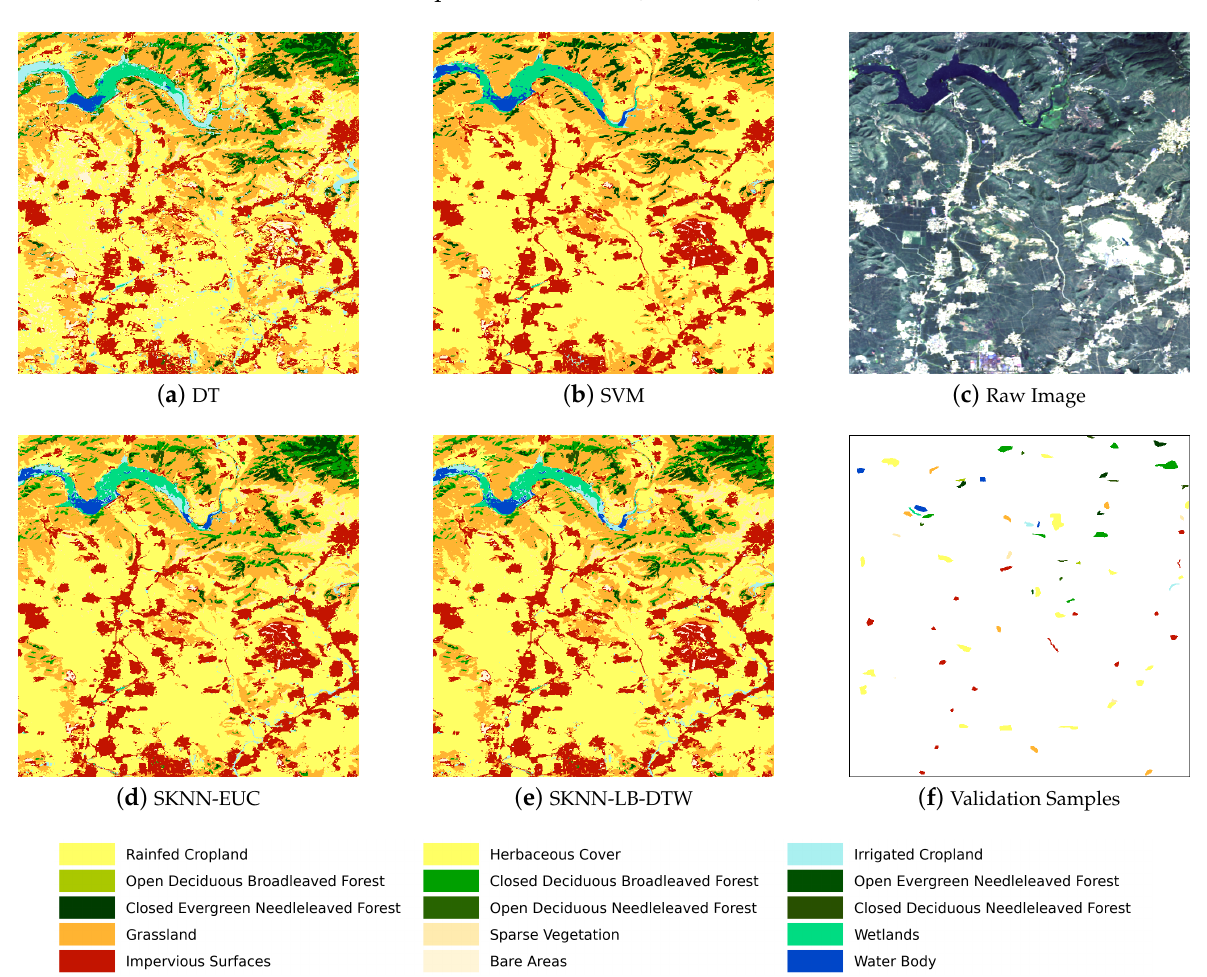
Figure 12. Comparison of classification maps of the fourth grid with the corresponding validation samples and a reference